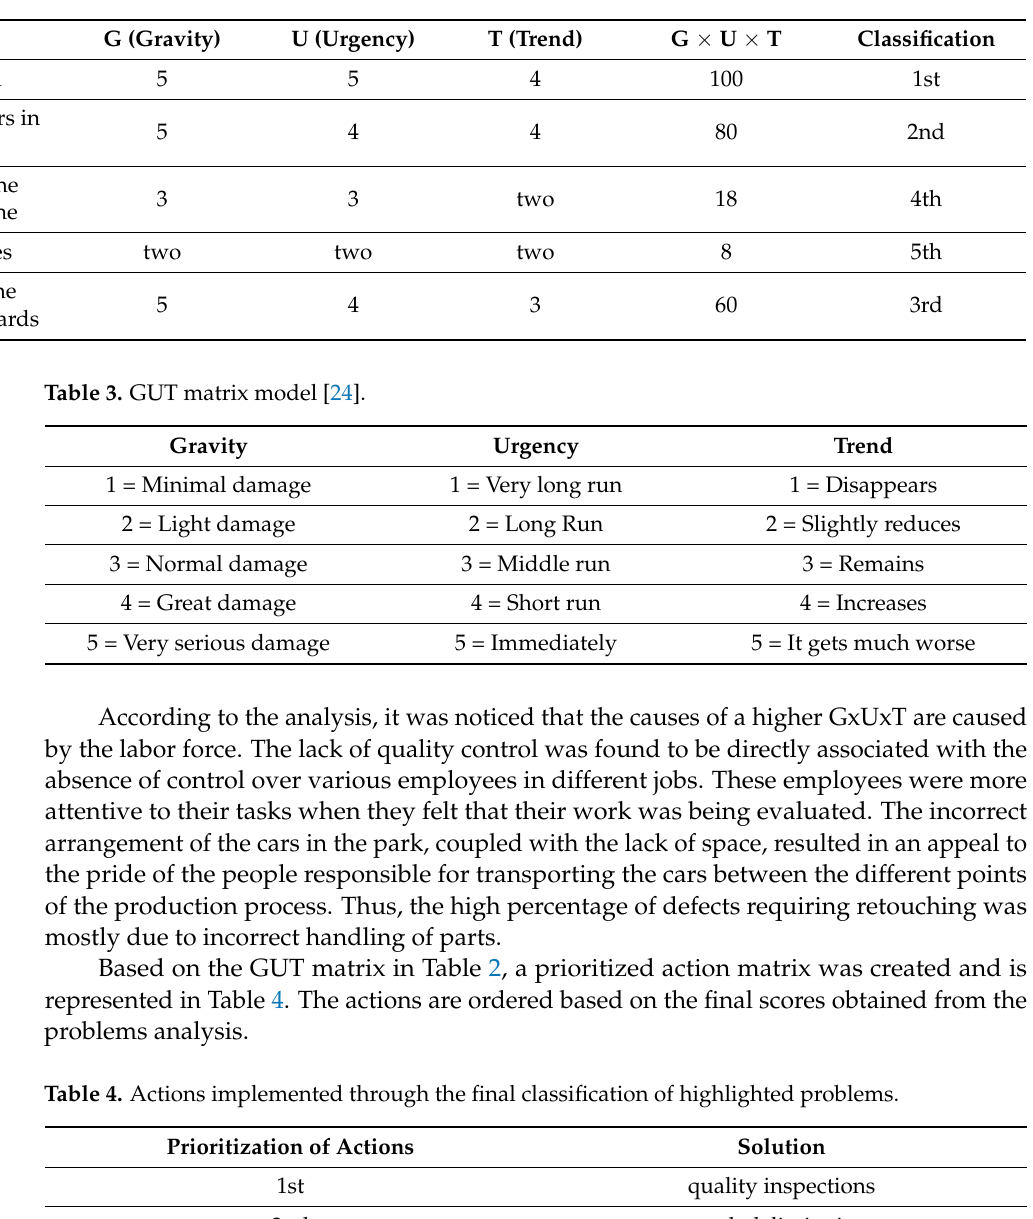
Table 2. GUT matrix for identified problems.